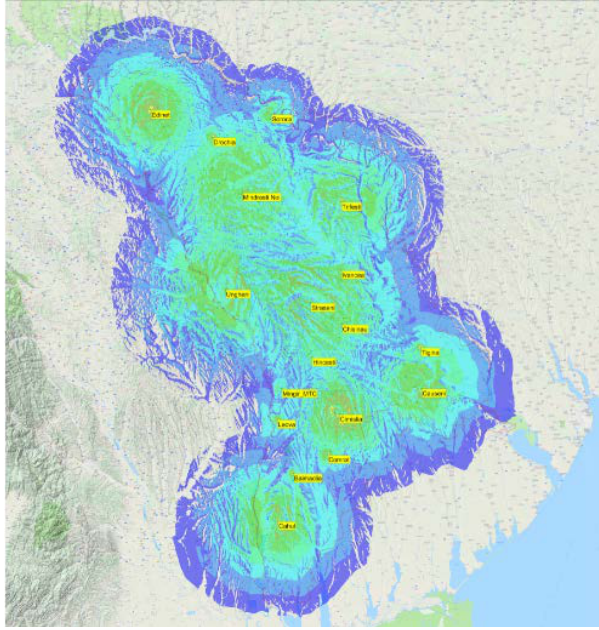
Figure 10. Mux-A coverage map in the transition regime (Simulcast).